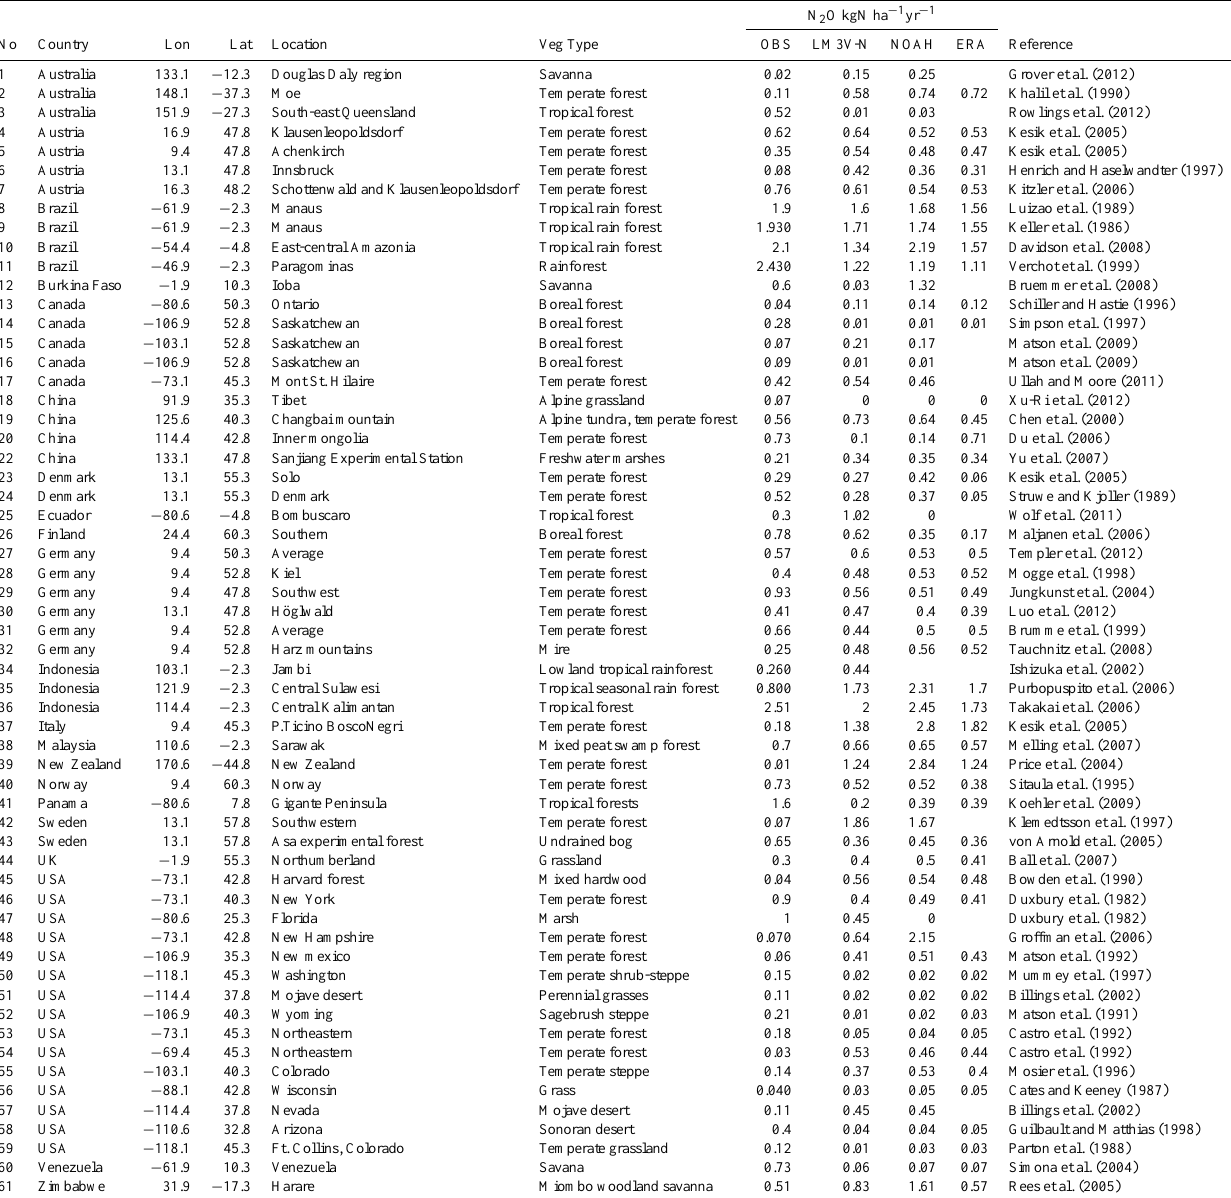
Table A1. Observed annual N 2 O emission data for model